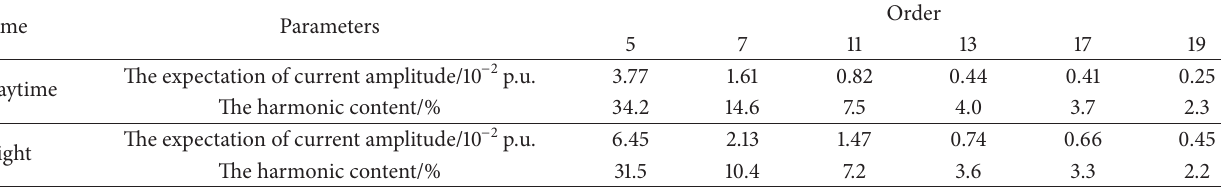
Table 5: The detailed information of charging station’s harmonics.